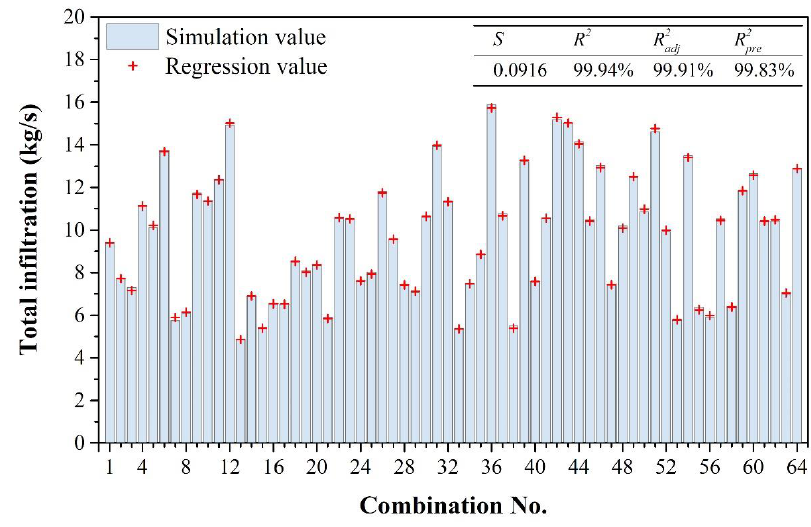
Figure 10. The total infiltration: the contrasts of simulation and regression values.